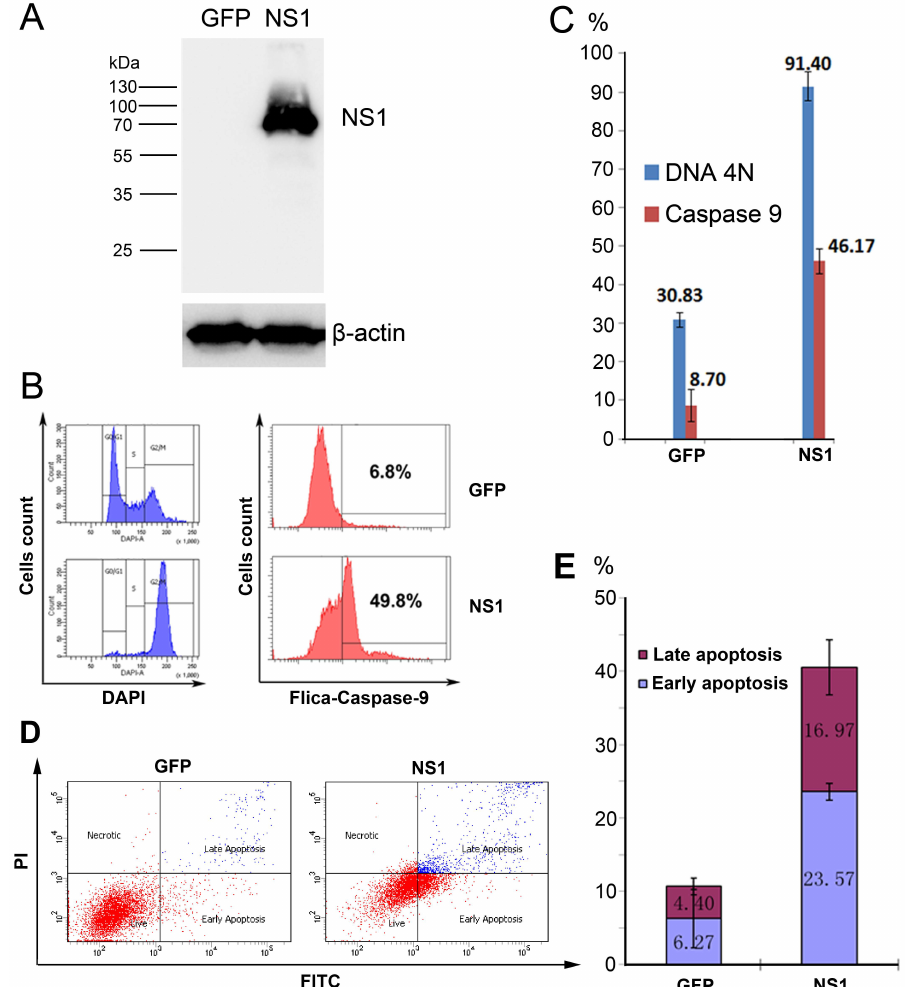
Figure 5. rAd5F11p-B19NS1-GFP induces cell cycle arrest at the G2 / M phase and apoptosis in UT7 / Epo-S1 cells. UT7 / Epo-S1 cells were transduced with rAd5F11p-GFP or rAd5F11p-B19NS1-GFP at an MOI of 100 vgc / cell. After 48 h post-transduction, ( A ) Western blotting. Transduced cells were collected for Western blot analysis using an anti-strep antibody. The same membrane was reprobed by using anti- β -actin antibody. ( B , C ) Cell cycle analysis and Fluorescent-Labeled Inhibitors of Caspases (FLICA). Transduced cells were fixed and stained using 4 (cid:48) ,6-diamidino-2-phenylindole (DAPI) or FLICA caspase-9. Cell cycle and caspase-9 activity were detected by flow cytometry. ( D , E ) Transduced cells were stained with Annexin-V FITC and Propidium Iodide (PI), followed by flow cytometry analysis. The percentages of both early and late apoptotic cells are presented with averages and standard deviations, which were obtained from at least three independent